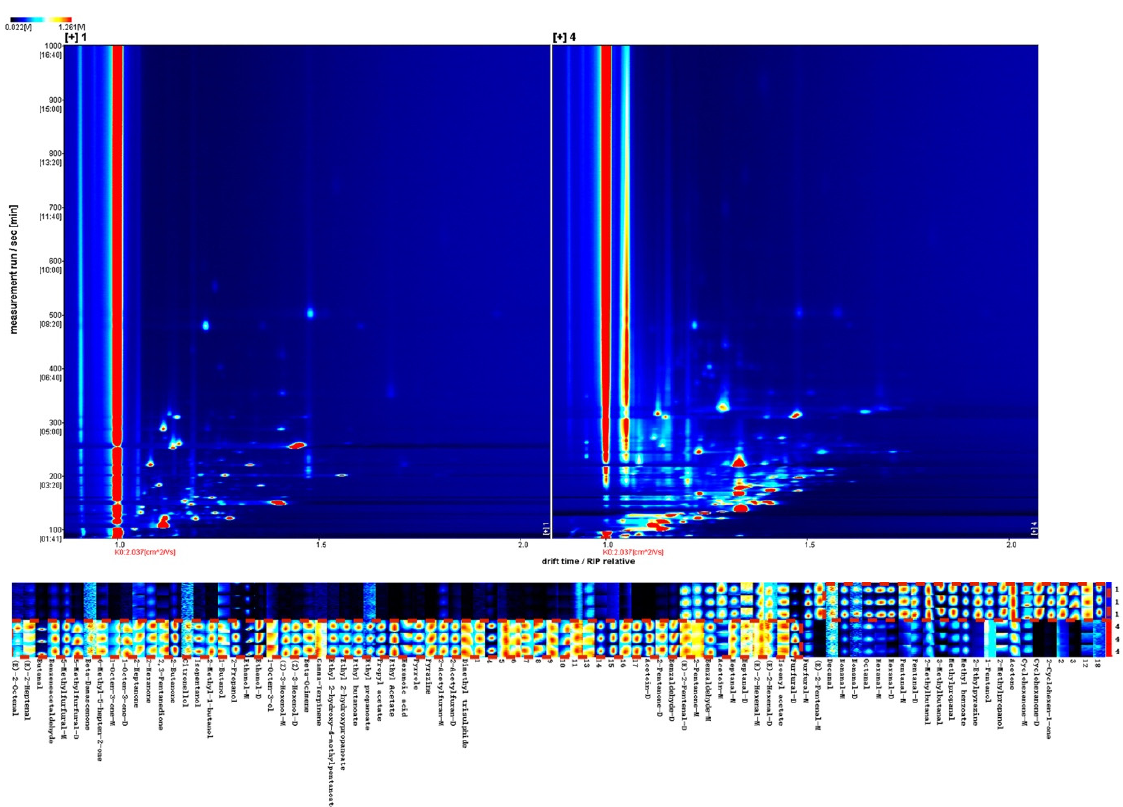
Figure 5. HS-GC-IMS topographic plots ( top panel ) and gallery plot fingerprints ( bottom panel ) of volatile flavor compounds in samples from group #1 and group #4. Top panel in left to right and bottom panel in top-down order.